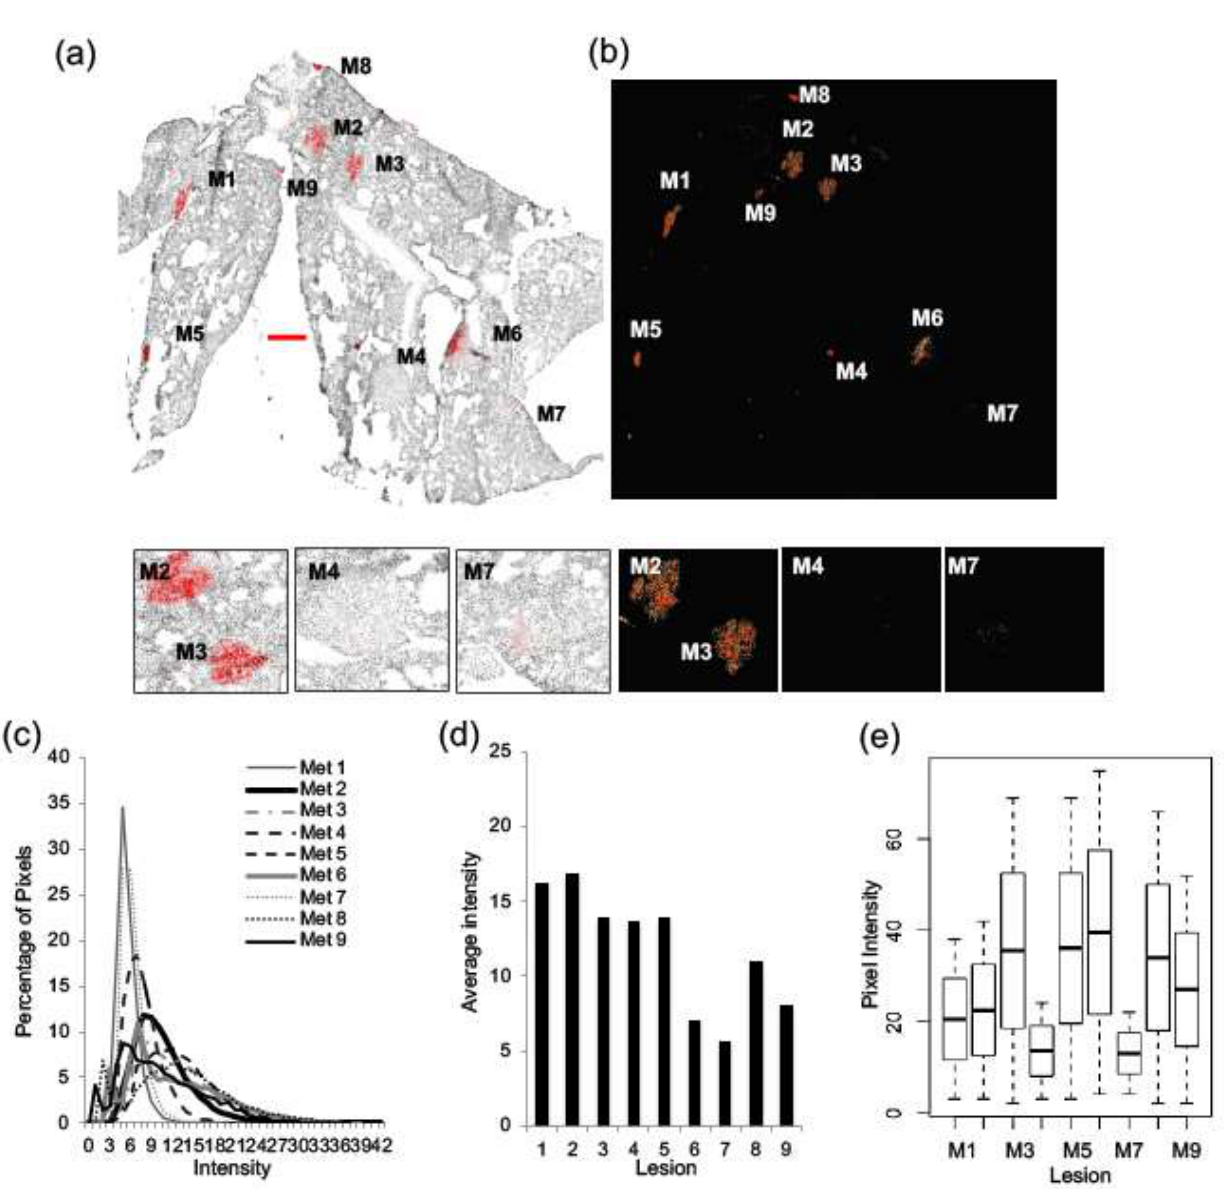
Figure 5. Significant inter-metastatic heterogeneity is seen for Her2/neu expression across lung lesions. Sections of lung tissue were probed for Her2/neu expression and imaged for Her2/neu (red) and Hoechst (grey) ( n = 3). A representative image of a section of lung tissue is shown ( a ), and metastatic lesions are identified as M1 through to M9. Selected lesions from the lung that represent high expression levels (M2 and M3), as well as low expression levels (M4 and M7), are shown. A heat map was generated from the greyscale image of Her2/neu fluorescence ( b ). Her2/neu expression was examined by looking at the distribution of pixels across intensity levels from 0 to 255 in each of the lesions within the tissue ( c ). The average pixel intensity for each lesion was also calculated and plotted ( d ). Boxplots were used to illustrate the distribution of pixels across intensity levels for each lesion within one lung section, and a Kruskal–Wallis test provided a statistically significant p -value (<0.0001) ( e ). Bar = 250 µm.